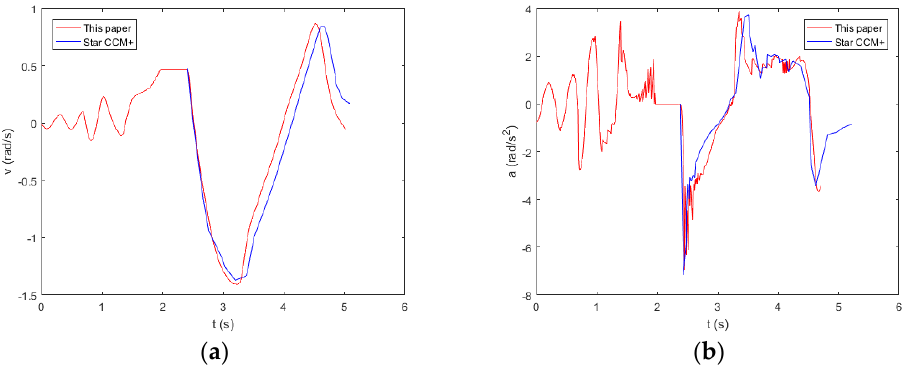
Figure 10. Velocity ( a ) and acceleration ( b ) of pitch of the lifeboat.